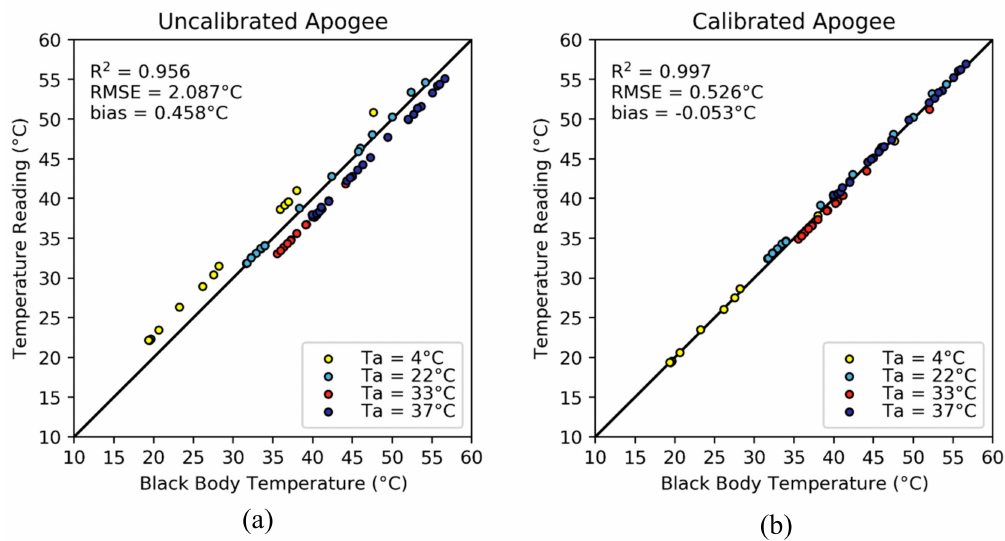
Figure 4. ( a ) A scatterplot of the uncalibrated Apogee measurements taken from inside the environmental chamber at di ff erent temperatures. The measurements from the Apogee sensor have a linear relationship with the reference black body temperature, but have a temperature dependent bias. ( b ) The scatterplot after the calibration process, showing reduced measurement bias and an improved RMSE. The plots and the statistics were made from the evaluation dataset (n =